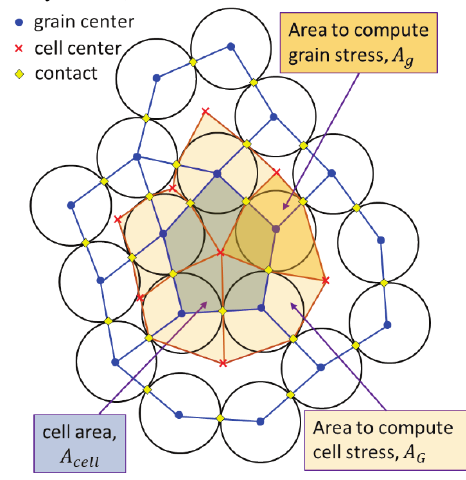
Fig. 3. The mean coordination number fraction for all the systems studied in this